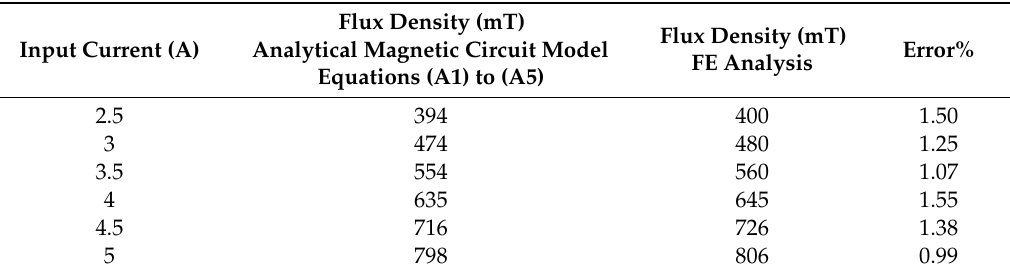
Table A1. Comparison of flux density values at the center of the air gap of the C-shaped electromagnet obtained by analytical magnetic circuit model (Equations (A1) to (A5)) and FE